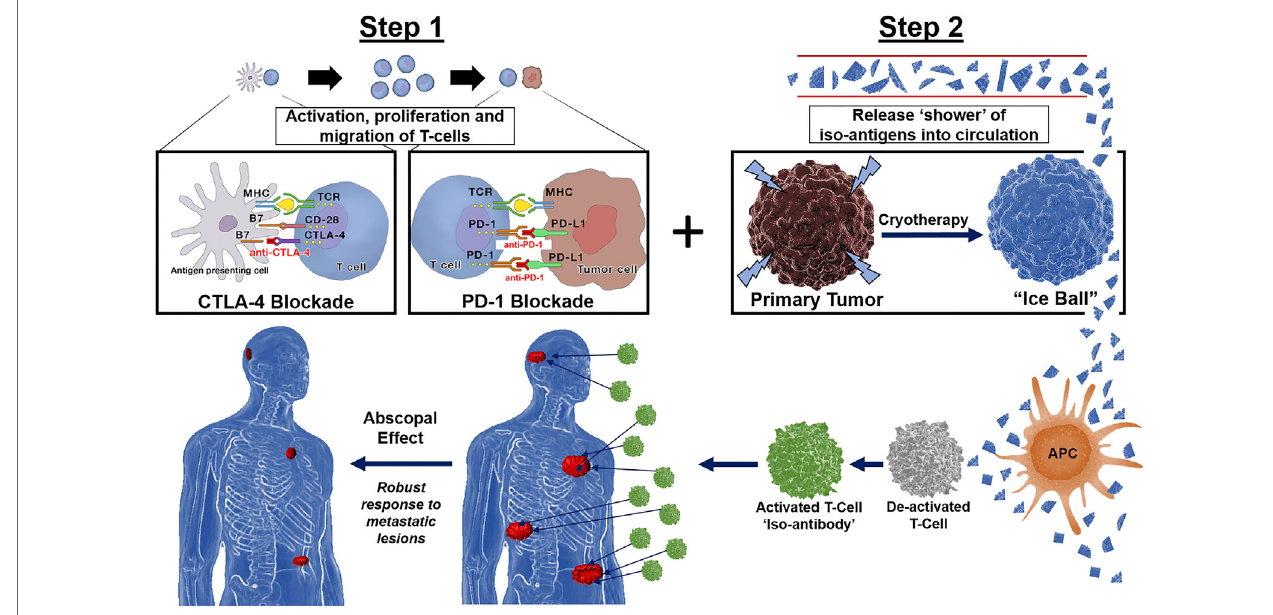
FiGURe 2 | Immunotherapy followed by cryotherapy for enhanced abscopal effect: If polyvalent, auto-inoculating tumor vaccines can be augmented and potentiated with the combined checkpoint inhibitors cytotoxic T-lymphocyte-associated protein (CTLA-4) and PD-1, then theoretically, a robust abscopal effect should be observed within the host, not only by cryosurgery tumor ablation/destruction of the primary lesion but also by abrogation of regional and distant metastases along with conferred immunity at both local and distant tumor sites. Hence, through synergistic processes these checkpoint inhibitors exert their effects on the immune processing of a large polyvalent vaccine caused by cryosurgical destruction and release of a large population of heterogenous tumor antigens; the hosts immune system should respond accordingly as is currently being witnessed and reported in the literature today via the very same processes encountered with radiation oncology in combination with these novel checkpoint inhibitors CTLA-4 and PD-1, yielding a robust cryosurgery-based abscopal